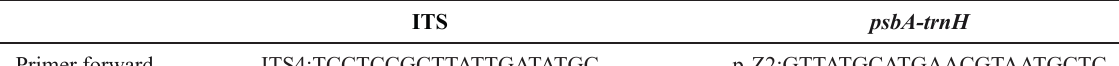
The sequence of primer for PCR.